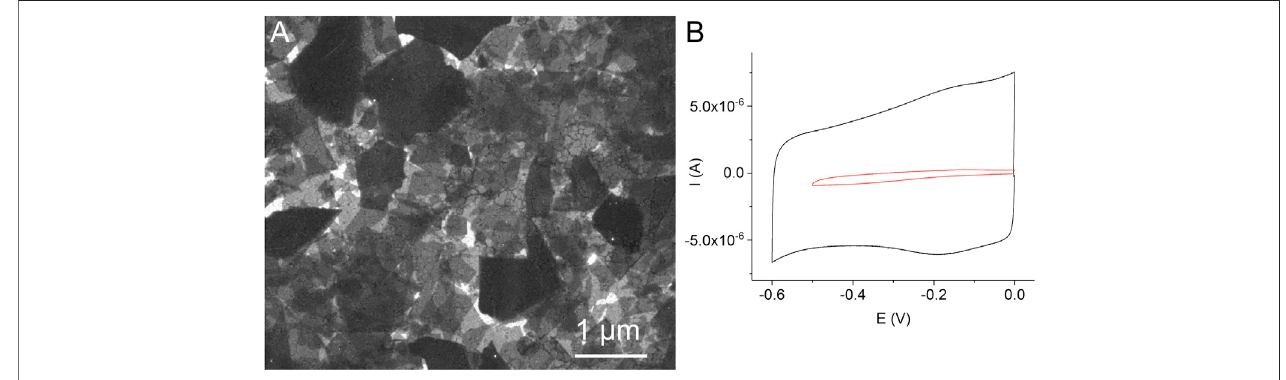
FIGURE2| ASEMimageofthethin- fi lmgoldelectrodewiththeelectrochemicallyreducedgrapheneoxide (A) .Cyclicvoltammogramsofabaregoldelectrode(red line) and a gold electrode modi fi ed with the electrochemically reduced graphene oxide (black line) in 0.1 M PB, scan rate 0.05 Vs − 1 , deaerated solutions (B)